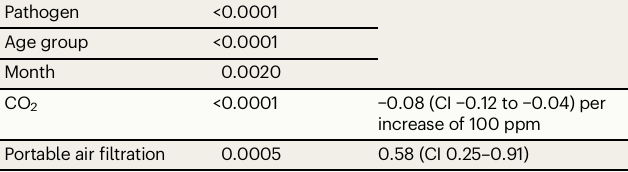
Panelaliststhefactorssigni fi cantlyassociatedwithpathogendetectioninalogisticregression model.Italso shows effect sizes (odds ratiosand 95% CI) for CO 2 andnatural ventilation,after adjustmentfor pathogen,agegroup and month.See SupplementaryTable 4 forunadjusted estimates. Panel b)liststhe factorssigni fi cantly associatedwithpathogen concentration (measuredinqPCRCtvalues)inalinearregressionmodel.Italsoshowseffectsizes(changeinCt value and 95% CI) forCO 2 andportable air fi ltration, after adjustment for pathogen, agegroup andmonth.SeeSupplementaryTable4forunadjustedestimates. P -valuesaretwo-sided.They wereestimatedusingtheChisquaredmethod(noadjustmentformultiplecomparisons).Almost identical results of alternative modelsare showninSupplementaryTable